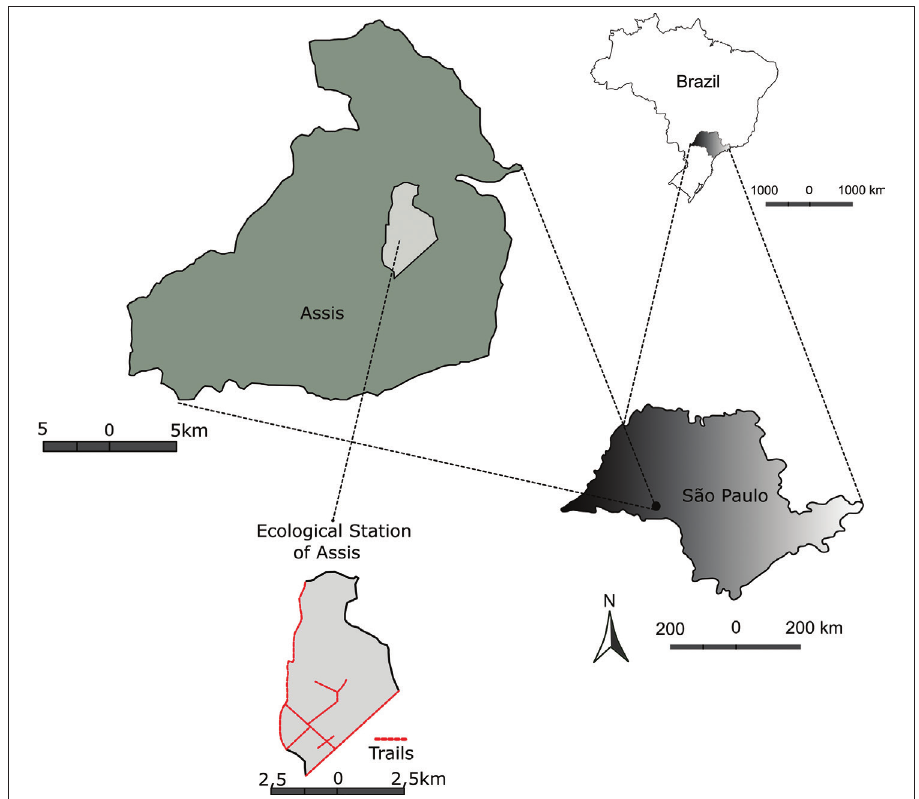
Figure 1. Study area, Estação Ecológica de Assis, state of São Paulo, Brazil (trails and edges sampled in